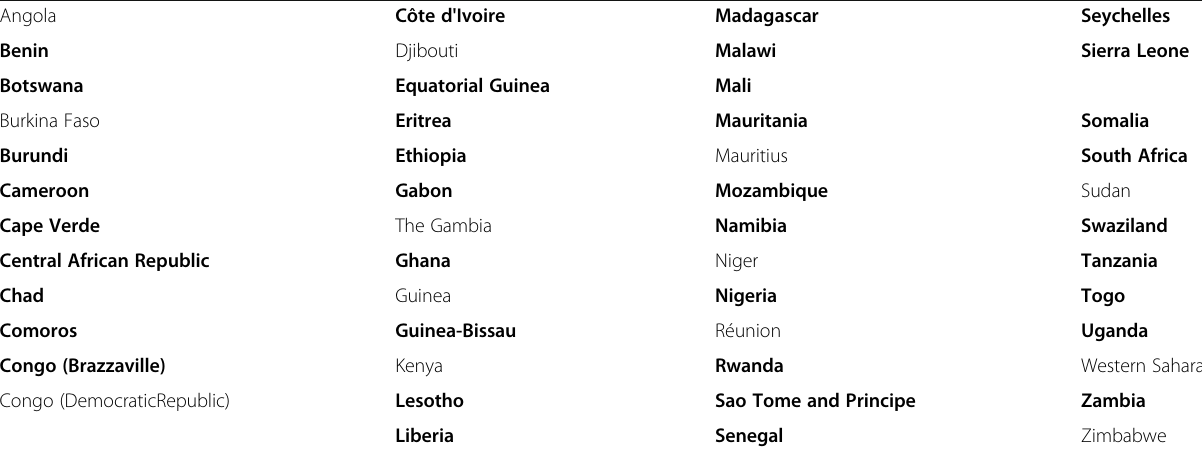
Table 3 Sub-Saharan African (SSA)